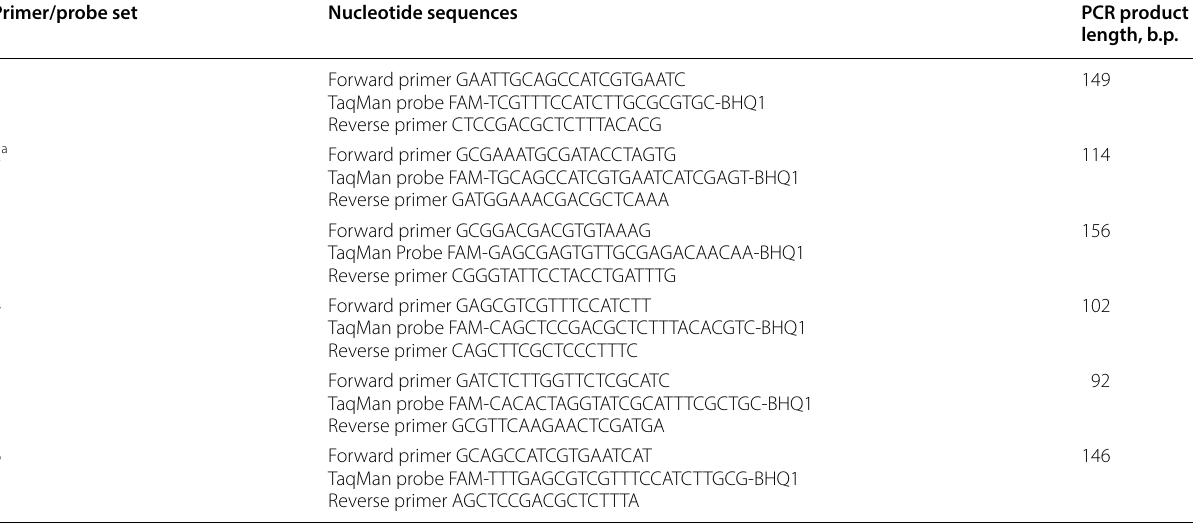
a The most optimal primer/probe sets for identification of P. kudriavzevii